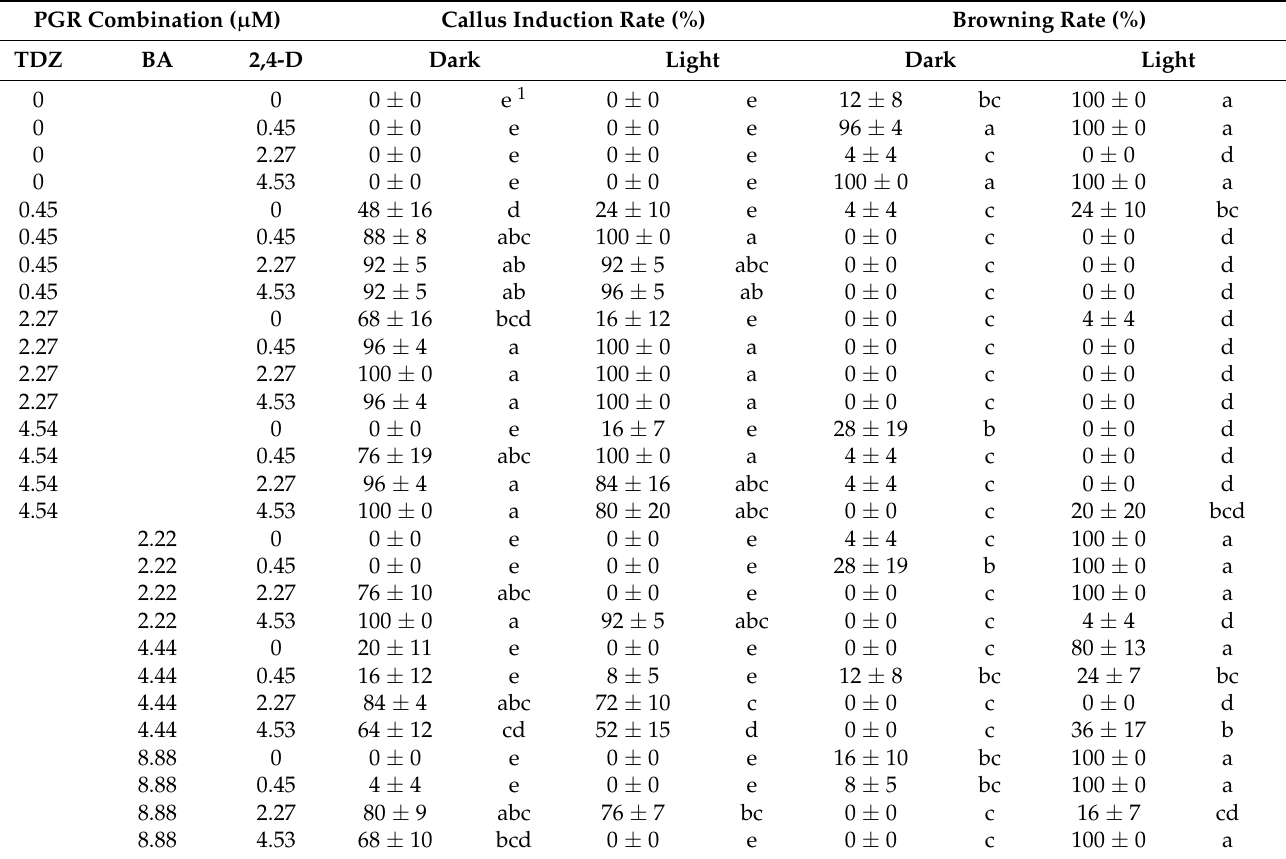
Table 1. Effects of the combination of thidiazuron (TDZ) or 6-benzylaminopurine (BA) plus 2,4-dichlorophenoxyacetic acid (2,4-D) on strawberry ( Fragaria vesca ) leaf explants after 4 weeks of culturing.